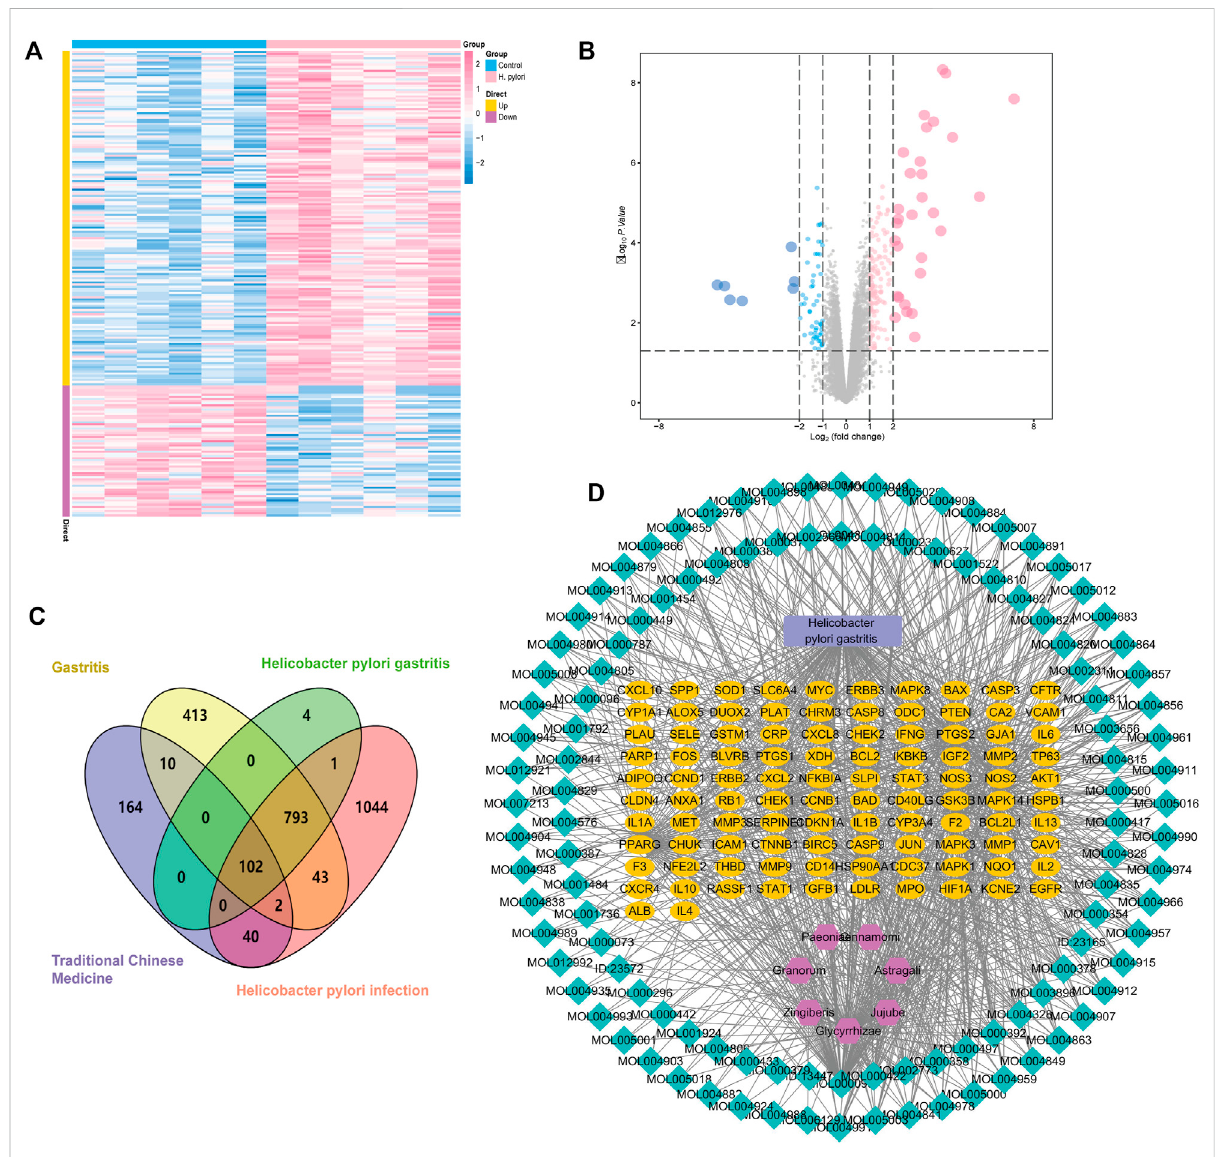
FIGURE 4 Potential targets of HQJZD in the treatment of H. pylori gastritis. (A) Cluster heat maps of the differential genes. (B) Volcano maps of the differentialgenes:pinkrepresentsthe647signi fi cantlyup-regulatedgenesandbluerepresentsthe253signi fi cantlydown-regulatedgenes. (C) Venn diagramofdiseasetargetsfromdifferentdatabasesandtargetsofHQJZD:purplerepresentsthe318targetsofactivecomponentsinHQJZD;yellow represents the 1363 targets of “ gastritis ” ; and pink represents the 2025 targets of “ Helicobacter pylori infection ” from the GeneCards database. Green represents the 2025 targets of 900 differential genes from GEO database. Finally, 102 intersection targets of HQJZD in treating H . pylori gastritis were obtained. (D) The “ active ingredients – disease – targets ” network was constructed and included 224 nodes and 998